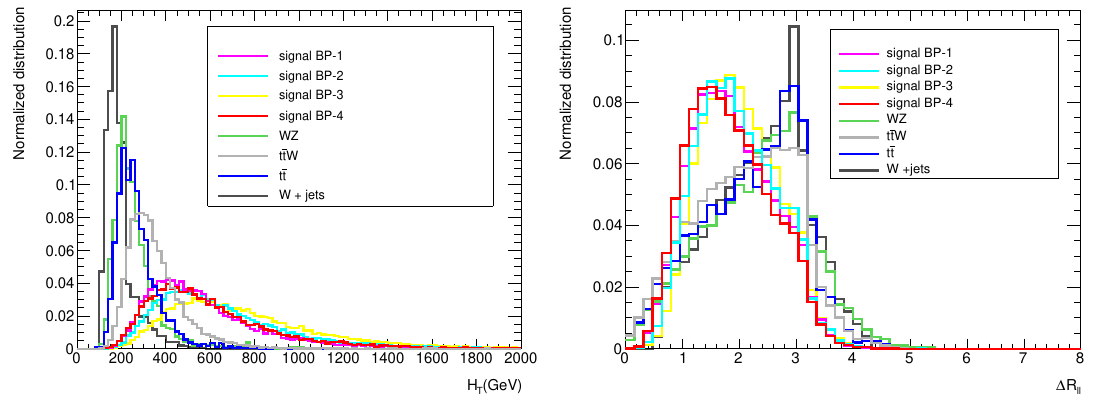
Figure 17 . Distribution of H T and (cid:1) R between leading and sub-leading leptons for the four signal BPs and backgrounds in case II.